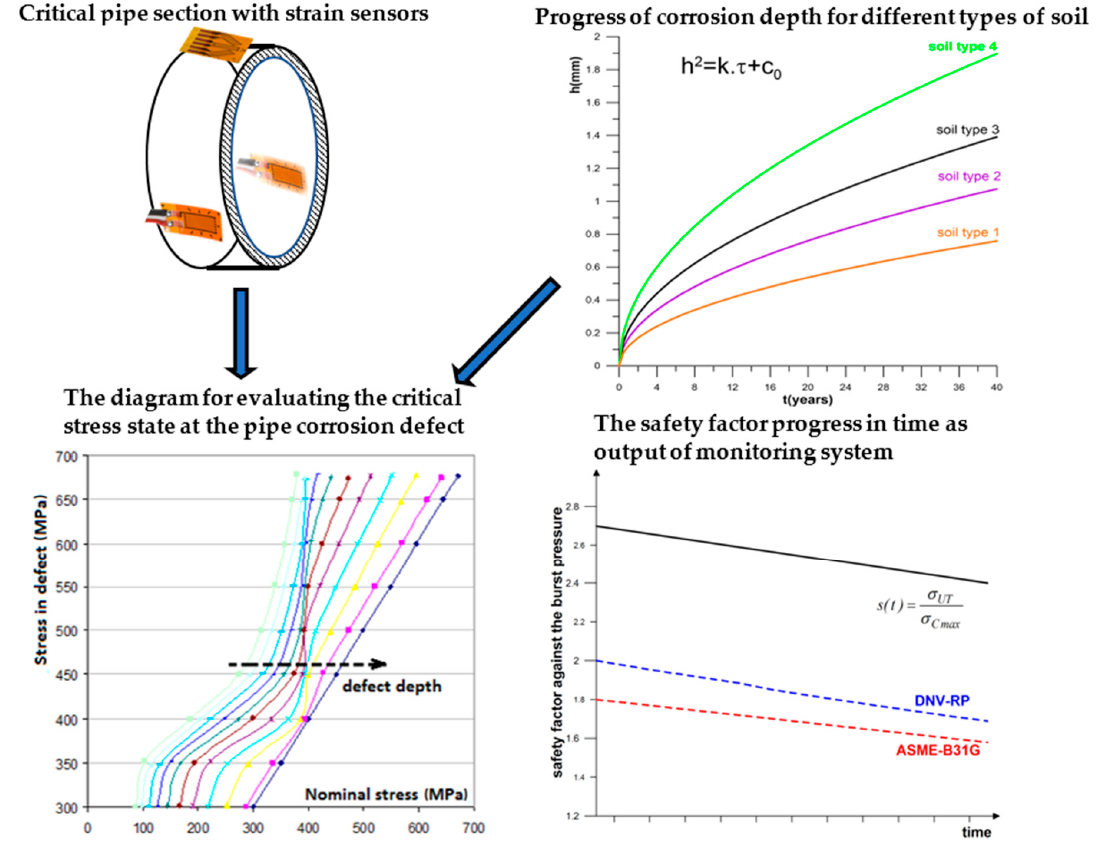
Figure 10. The schematic concept of the online monitoring of a pressurized pipeline system with corrosion defects.